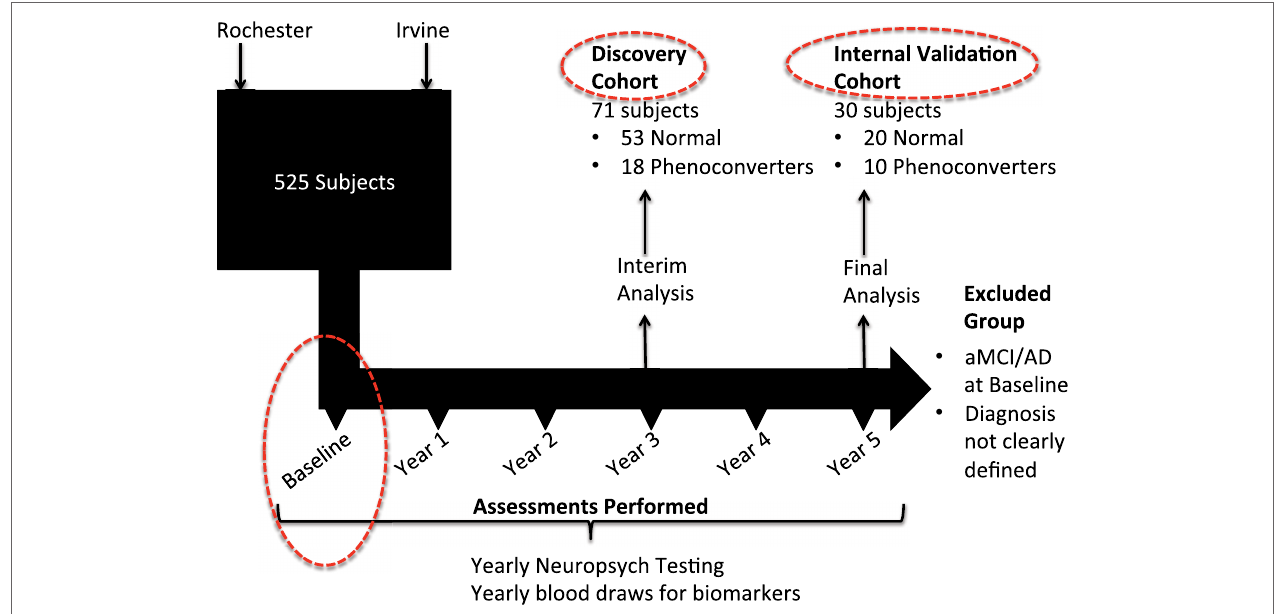
FigUre 1 | schematic representation of overall study design and specific analyses reported in this paper . Clinical subjects for the 5-year observational study were selected for participation at the University of Rochester and the University of California Irvine. An interim analysis was performed at year 3 of the study, comparing 53 subjects who maintained normal cognition since baseline study entry, to a group of 18 subjects who were cognitively normal at baseline but had phenoconverted to either aMCI or AD by year 3. This group made up our discovery cohort from which initial biomarker discovery was performed. With complete neuropsychological assessments available by study termination, an additional group of 10 subjects were noted to have phenoconverted during year 4 and year 5. This latter group was combined with a group of 20 matched subjects who maintained normal cognition throughout the study, and together were designated as the internal validation group (or cohort). All subjects included in this analysis (Discovery and Internal Validation cohorts) had only their baseline blood specimens assessed for metabolomic biomarker comparisons (dashed red